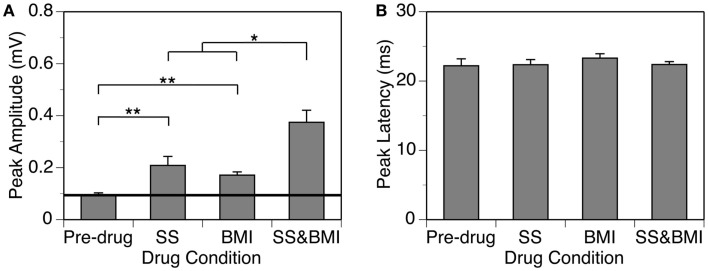
Group results (n = 9) obtained at 10 dB above the MT showing effects of individual applications of SS and BMI (two middle bars) and a simultaneous application of the drugs (the right bar) on the peak amplitude (A) and the peak latency (B) of the DN. The horizontal line in (A) represents the mean peak amplitude of the DN obtained before drug application. Double stars indicate statistical significance at the level of p < 0.005. A single star indicates statistical significance at the level of p < 0.05. Error bars represent SE.